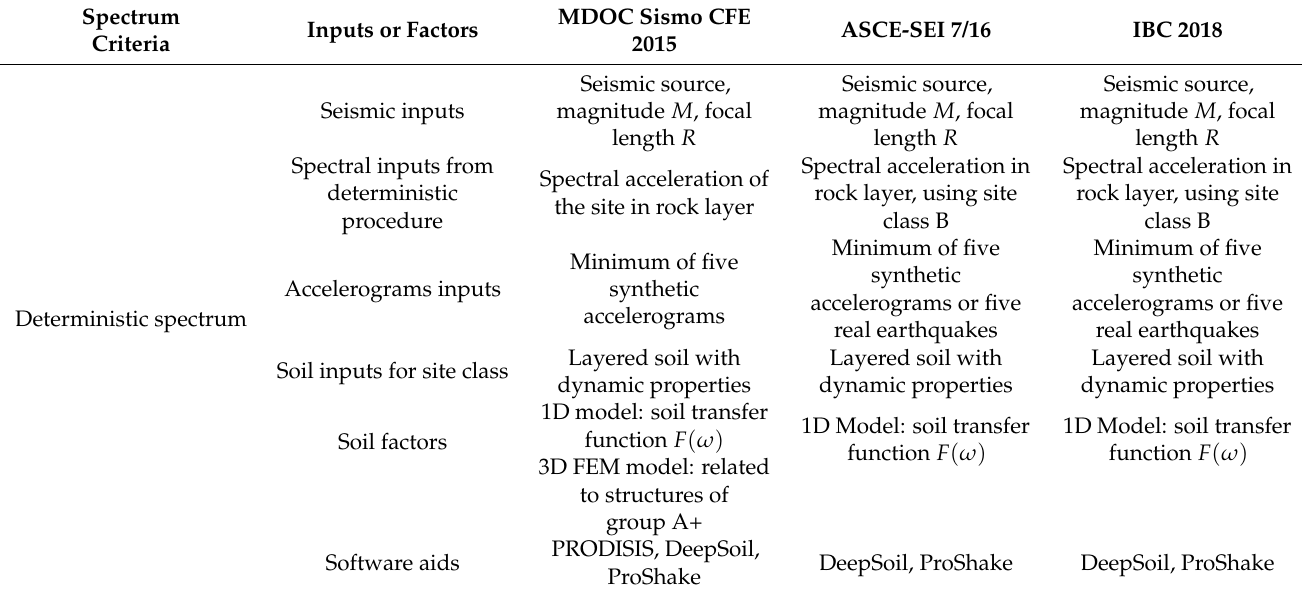
Table 10. Deterministic seismic response spectra criteria and comparison between